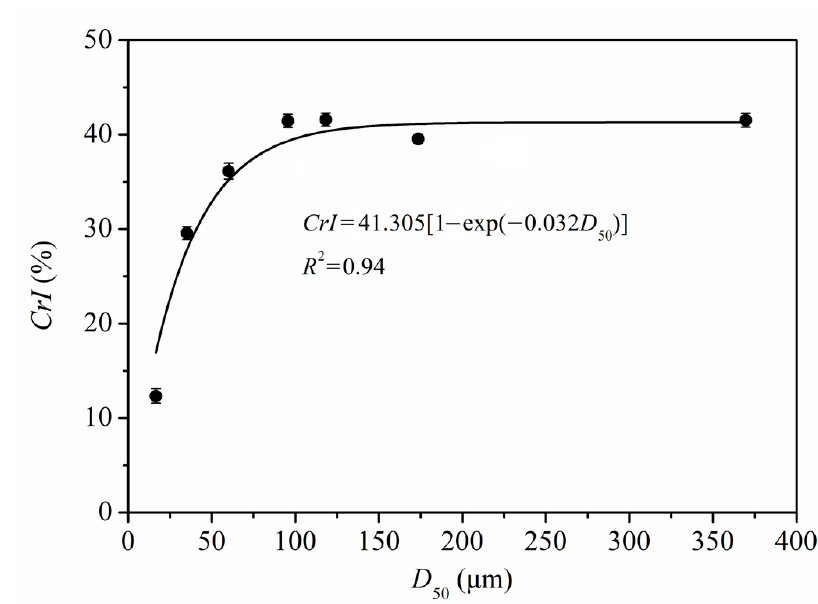
Figure 6. Quantitative relationship between CrI and D 50 of PIDF.